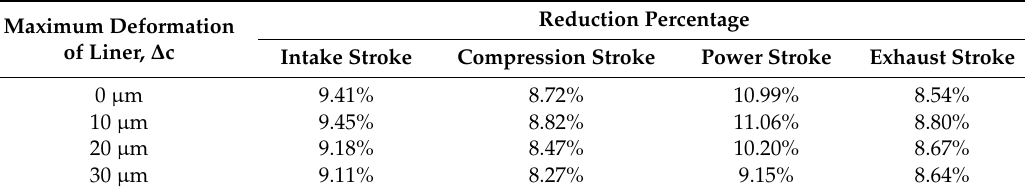
Figure 10. Hydrodynamic friction forces in the textured RLC and untextured RLC: ( a ) Δ c is 0 μ m; ( b ) Δ c is 10 μ m; ( c ) Δ c is 20 μ m; and ( d ) Δ c is 30 μ m.